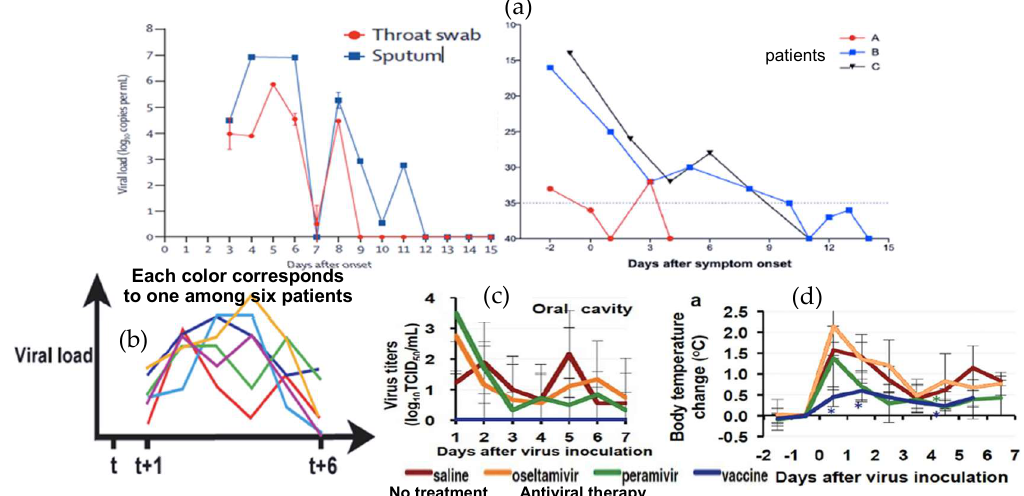
Figure A1. ( a ) Viral load in real COVID-19 patients [10], ( b ) in influenza-simulated patients [57] and ( c ) in real influenza- infected animals (red curve [58]), and ( d ) body temperature in real influenza-infected animals (red curve